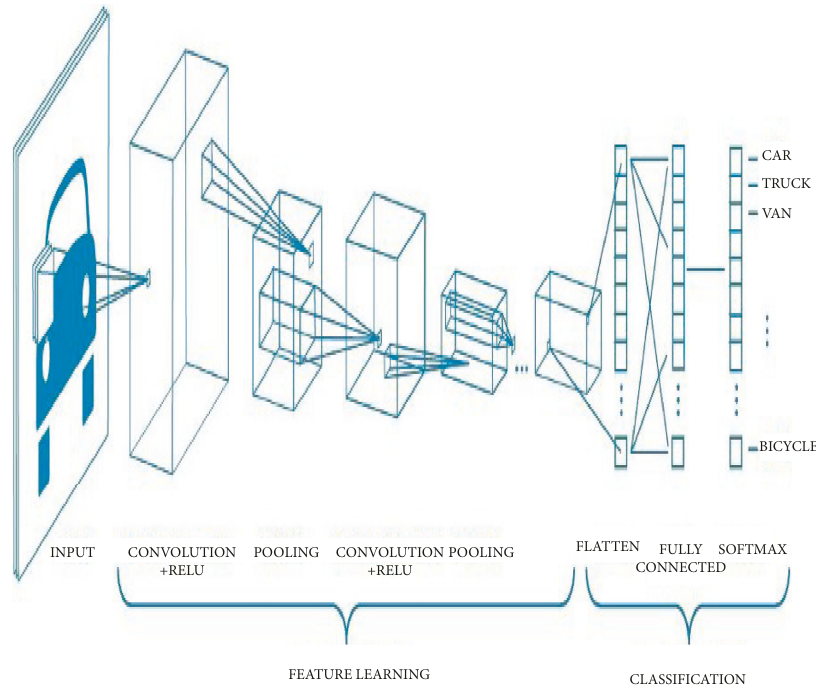
Figure 3: Diagram of convolutional neural networks.